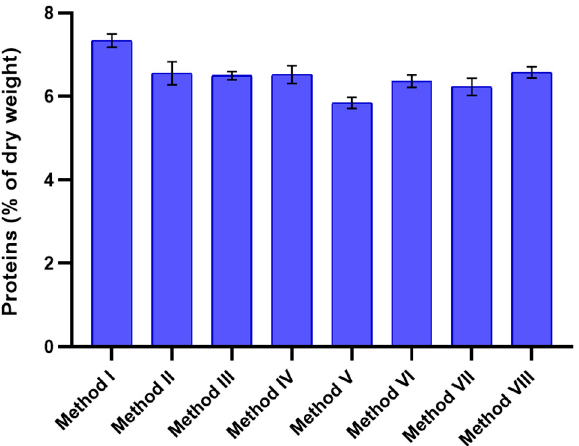
Figure 2. Comparison of different cell lysis methods for the recovery of intracellular proteins from Rhodomonas sp.